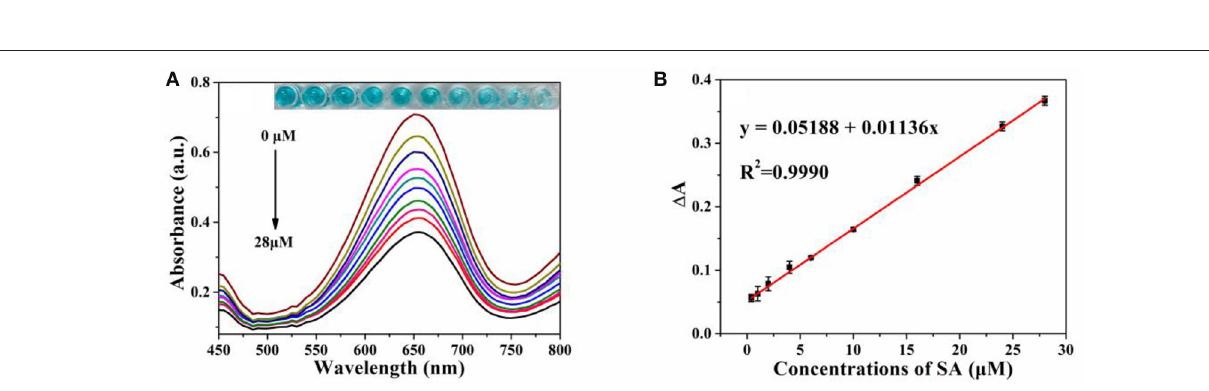
Frontiers in Chemistry |